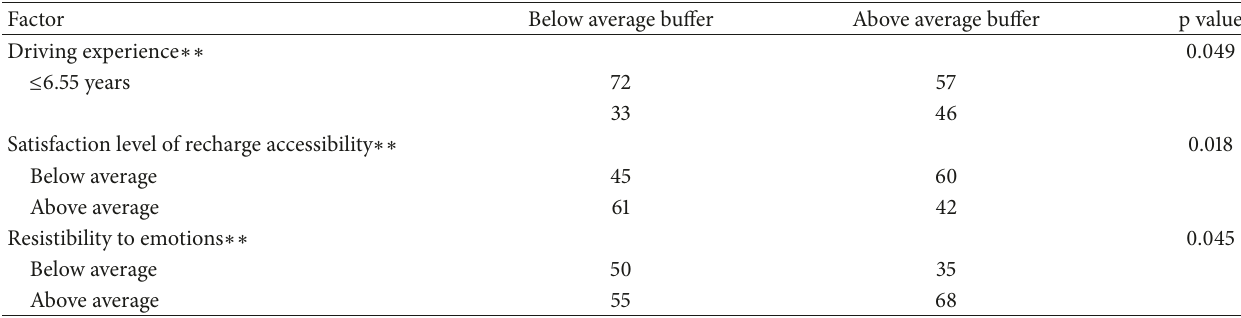
Table 5: Chi-square test results of factors that may be related to general safety buffer (factors with p value < 0.05 marked with ∗∗ and factors with p value < 0.01 marked with ∗ ∗ ∗ , the same to the following tables).